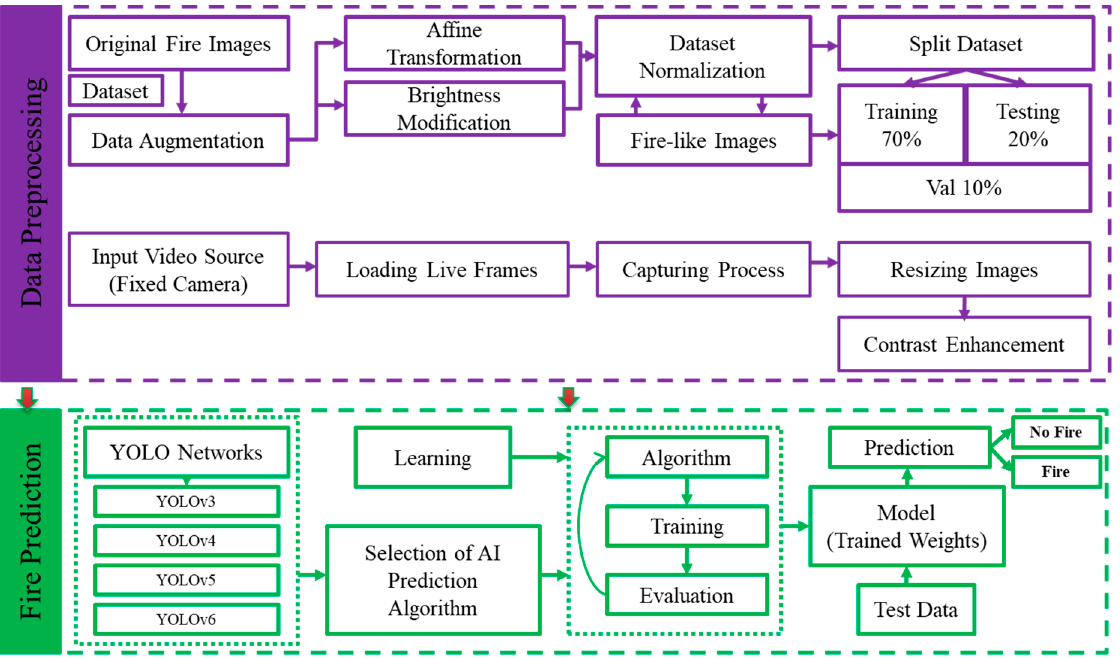
Figure 3. Flowchart of the proposed fi re detection and classi fi cation approach.